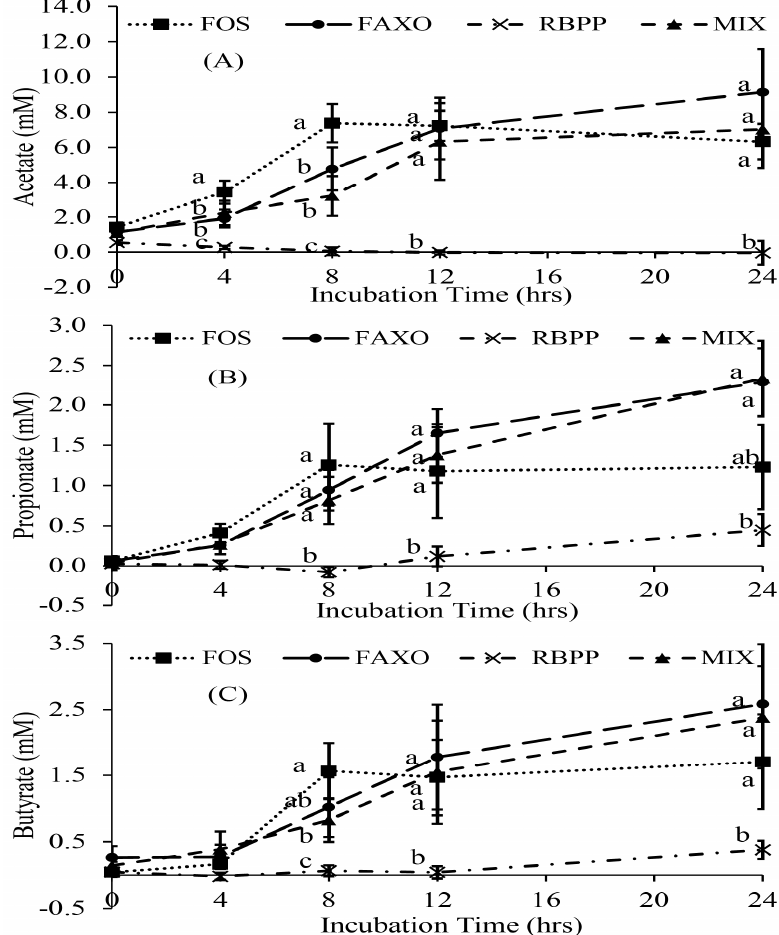
Figure 1. Individual SCFA (Short-Chain Fatty Acid) production during in vitro fermentation. ( A ) Acetate production; ( B ) propionate production; ( C ) butyrate production. Data are expressed as mean + SEM. Different letters at the same incubation time denote significant difference ( p < 0.05). FOS: fructooligosaccharides, FAXO: feroloylated arabinoxylan oligosaccharides, RBPP: rice bran polyphenols, MIX: mixture of FAXO and RBPP.